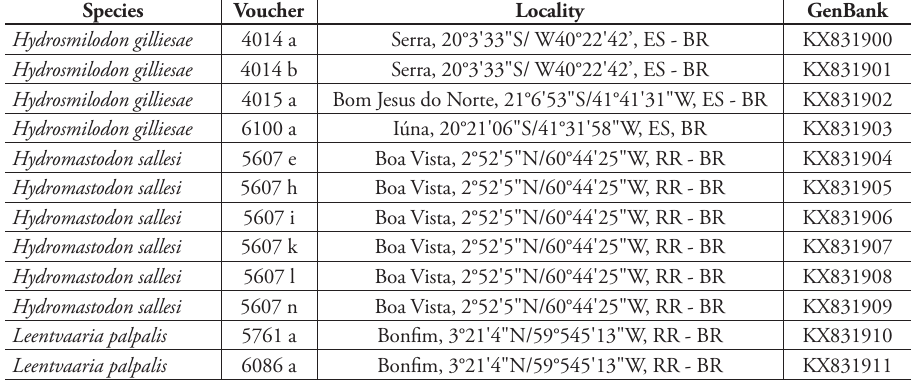
Table 1. Collection information for specimens analysed in this study. Specimen information includes: species name, voucher number, locality (ES, State of Espírito Santo; RR, State of Roraima; BR, Brazil) and GenBank Accession Number.